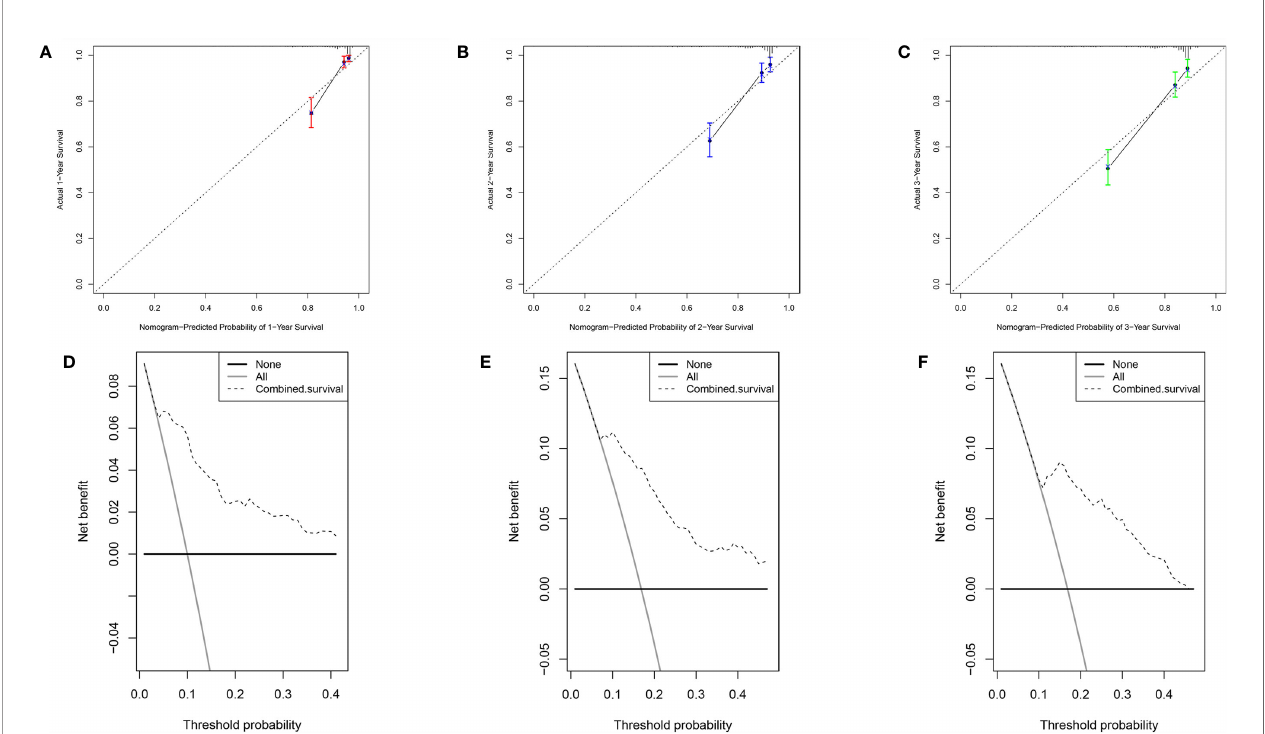
FIGURE 9 | Veri fi cation of the nomogram performance. (A) The calibrate curve of 1st year. (B) The calibrate curve of 2nd year. (C) The calibrate curve of 3rd year. (D) The DCA plot of 1st year. (E) The DCA plot of 2nd year. (F) The DCA plot of 3rd year.